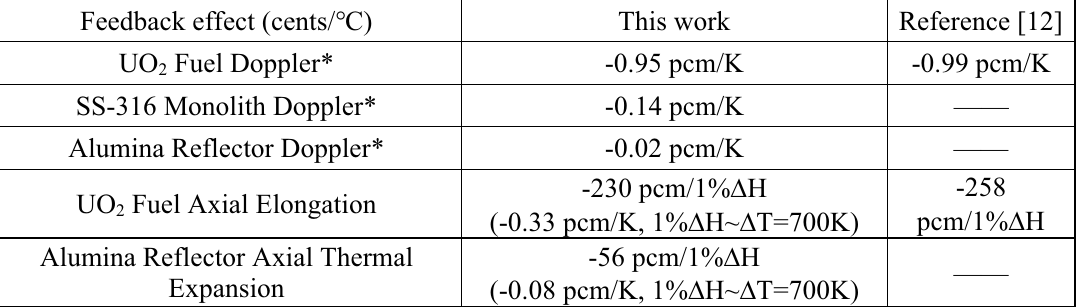
Table 1 Reactivity coefficients of various feedback